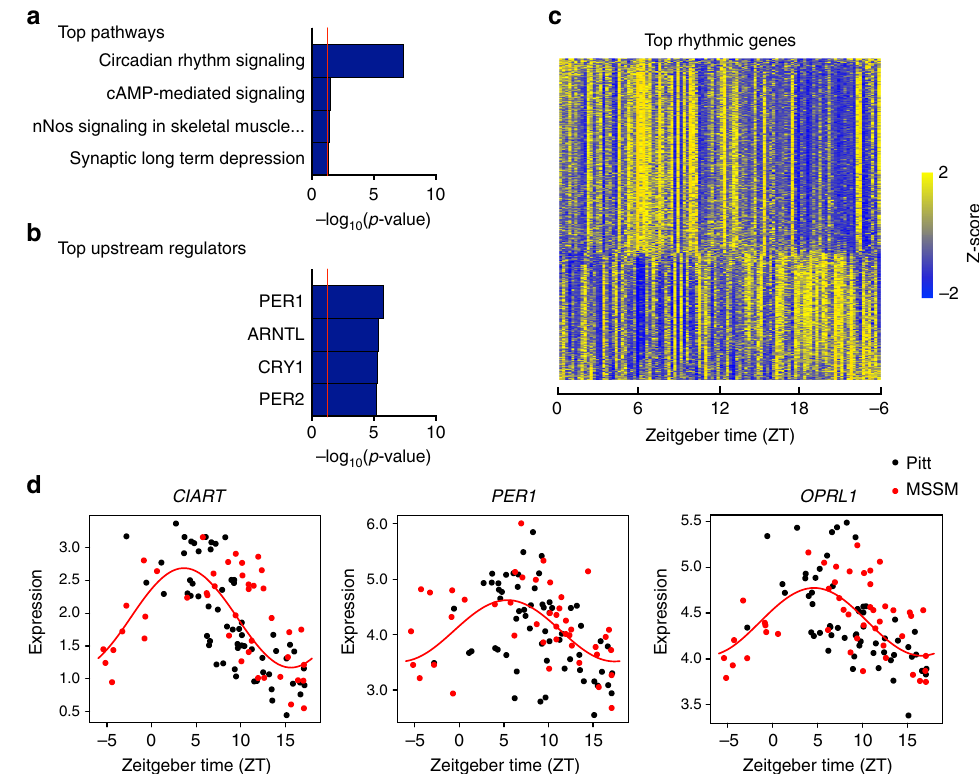
Fig. 1 Circadian rhythms in gene expression in human DLPFC in healthy control subjects. Nonlinear regression was used to detect circadian gene expression patterns based on individual TODs. Sinusoidal curves were fi tted using the nonlinear least-squares method and the coef fi cient of determination (R 2 ) was used as a proxy of goodness-of- fi t. A null distribution of R 2 generated from 1,000 TOD-randomized expression data sets was used to estimate the empirical p-value by comparing observed R 2 and the null distribution of R 2 . a The top pathway represented by these rhythmic genes is Circadian rhythm signaling. b The top predicted upstream regulators are core circadian genes. c Heatmap for circadian genes for all 104 healthy subjects ( p < 0.01). Expression levels are Z-transformed for each gene, and the genes are ordered by their circadian phase value (peak hour). Each column represents a subject and the subjects are ordered by time of death. d Scatterplots representing rhythms in gene expression for the top 3 circadian genes in healthy controls. Each dot indicates a subject with x -axis indicating the time of death (TOD) on ZT scale ( − 6 to 18 h) and y -axis indicating gene expression level. Subjects from the Pitt brain bank are in black while subjects from the MSSM brain bank are in red. The red line is the fi tted sinusoidal (Fig. 2e, g). The rhythmic genes in control subjects separate into 2 clusters; the top pathway for cluster 1 is circadian rhythm signaling, while the top pathways for cluster 2 relate to in fl ammation (Supplementary Figure 3). Interestingly, while the genes that are rhythmic in control subjects (Fig. 2d) do not have the same pattern of rhythmicity in subjects with schizophrenia, these genes may have a different temporal pattern of expression (e.g., 12-h rhythms) in schizophrenia (Fig. 2e). We next asked which genes lose or gain rhythmicity in subjects with schizo- phrenia compared to controls. Indeed, in schizophrenia, 424 transcripts lose rhythmicity, while 560 transcripts gain rhythmi- city (Supplementary Data 6). Most of the rhythmic genes in one group fail to show rhythmicity in the other group, and vice versa (Fig. 3a, b). Taken together, these results suggest that subjects with schizophrenia have a very different set of diurnally rhythmic genes and a different rhythmic pattern in the dlPFC compared to control subjects.